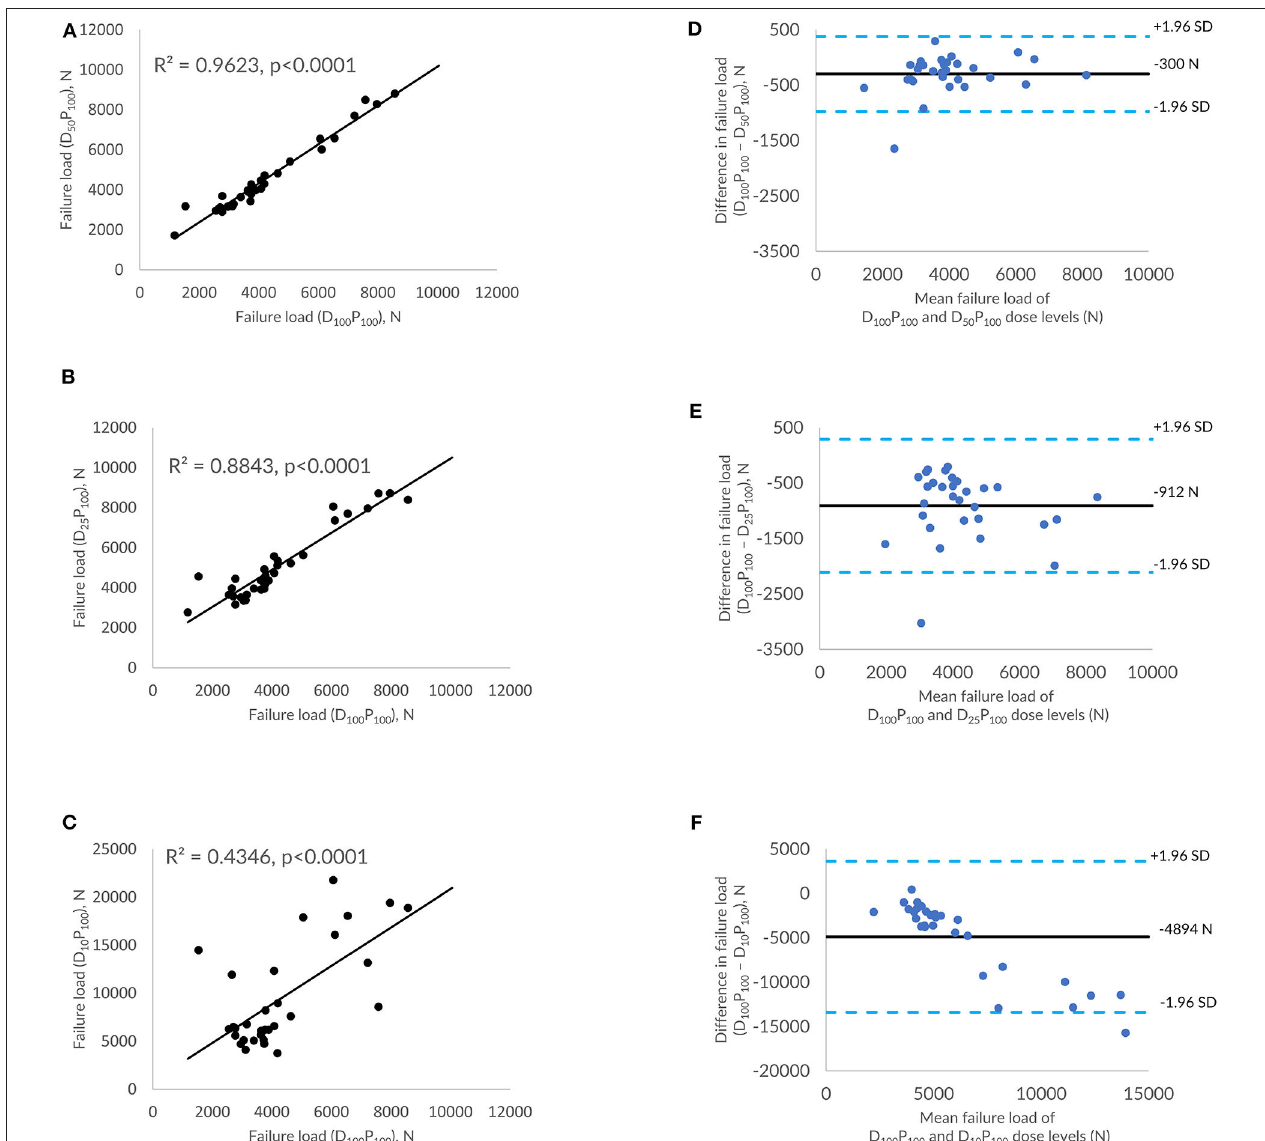
FIGURE 4 | Effect of dose reduction through reduced tube current on FE-predicted failure load values. (A) correlation plot between FE-predicted failure load values of original dose (100%) and 50% reduced dose, (B) correlation plot between FE-predicted failure load values of original dose (100%) and 75% reduced dose, (C) correlation plot between FE-predicted failure load values of original dose (100%) and 90% reduced dose, and (D–F) Bland-Altman plots representing the mean of FE-predicted failure load values vs. difference between them. Horizontal lines represent mean and dashed line ± 1.96 standard deviation. FL represents FE-predicted vertebral failure load